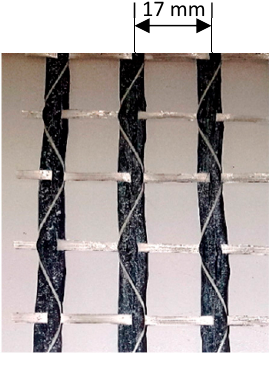
Figure 1. Carbon fabric.